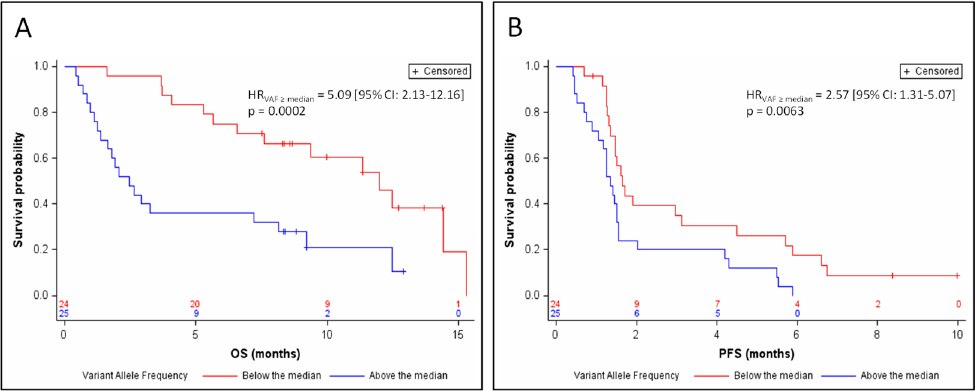
Figure 2. Kaplan–Meier estimates of overall survival ( A ) and progression-free survival ( B ), depending on relative ctDNA abundance (below or above the median).